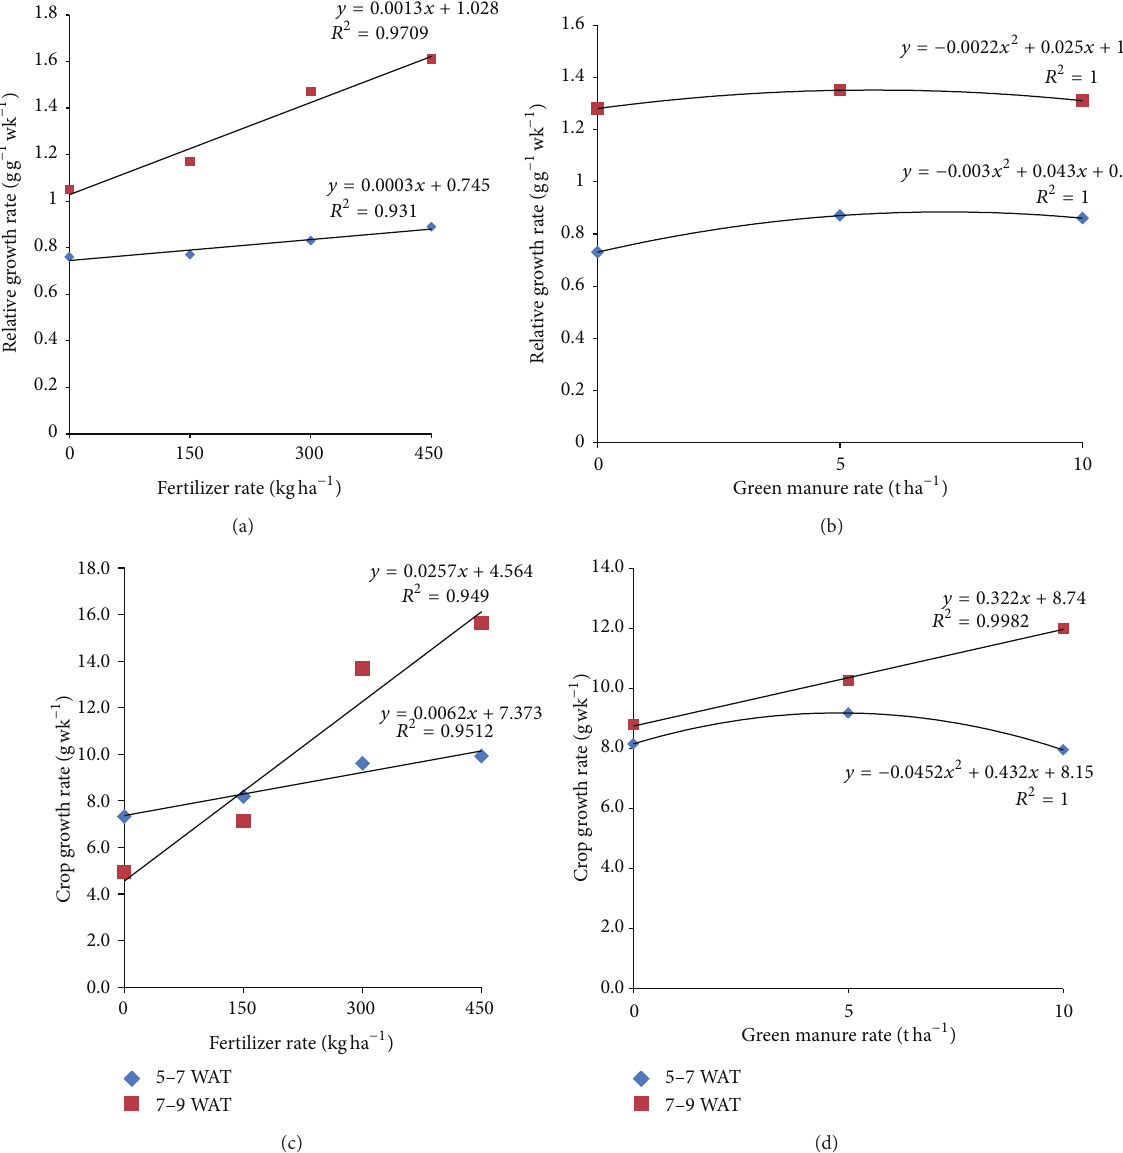
(Figure 2(a)), the response followed the regression equations 2 at 5–7 WAT 𝑦 = 0.000 𝑥 + 0.745 ( 𝑅 = 0.931) and 7–9 WAT 𝑦 = 0.001 𝑥 + 1.028 ( 𝑅 2 = 0.970) while CGR at 5–7 WAT 𝑦 = 2 = 0.949) and 7–9 WAT 𝑦 = 0.006𝑥 + 7.373 0.025 𝑥 + 4.564 ( 𝑅 ( 𝑅 2 = 0.951),